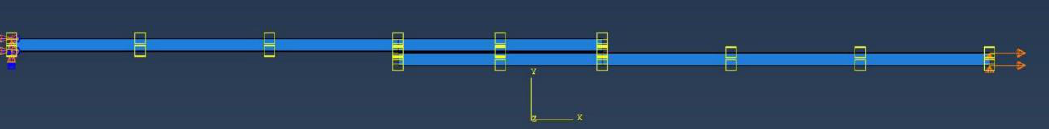
Figure 4. Geometry and boundary conditions of the SLJ model.